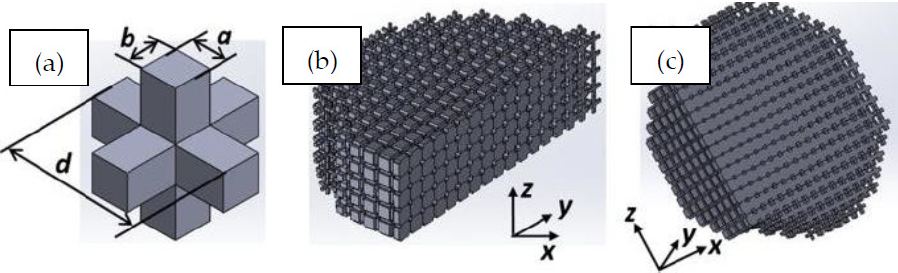
Figure 44. The geometry of the flattened Luneburg lens designs, fabricated using polyjet technology, showing ( a ) the periodic unit-cell of both lenses with dimensional variables appropriately labelled—this proposed building block can form a uniform 3D lattice once connected to adjacent, identical unit-cells; and ( b ) the 2D and ( c ) 3D lens designs printed with 5 and 19 stacked layers, respectively. (Reprinted from [168], with the permission of AIP Publishing).